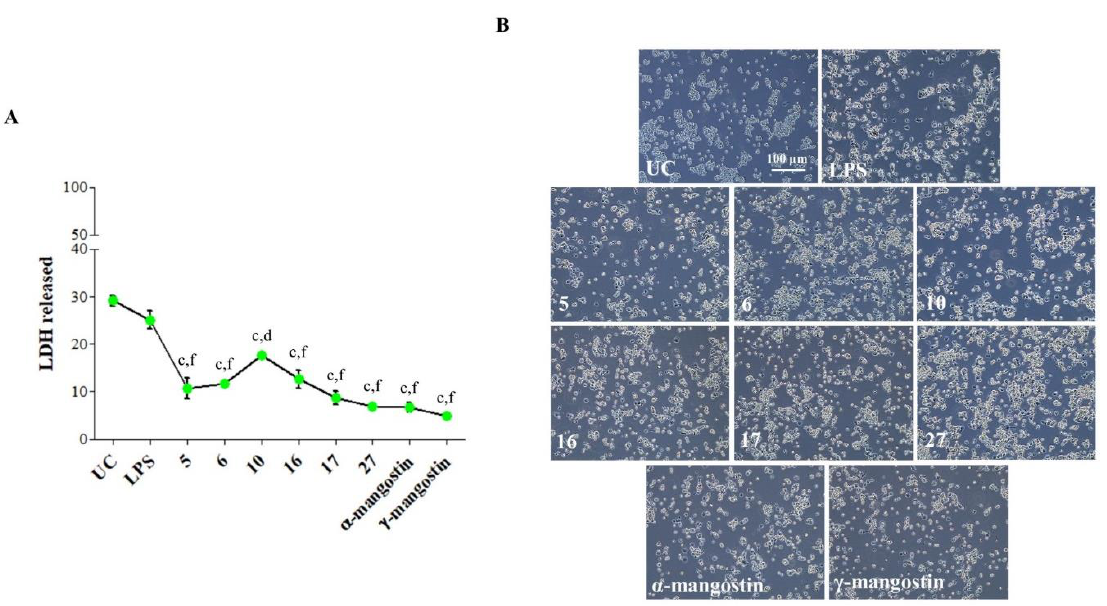
Figure 1. Cytotoxicity occurrence in inflamed macrophages in the presence of compounds 5 , 6 , 10 , 16 , 17 , 27, and mangostins after 24 h of exposure. ( A ) The trend line graph shows the percentage of LDH released from cells in all the experimental conditions. Values are normalized on 3-(4,5-dimethylthiazol-2-yl)-2,5-diphenyltetrazolium bromide (MTT) data obtained from the same experiment. ( B ) Images from a representative experiment. UC = untreated cells (cells pre-incubated with BSO for 18 h). LPS = cells stimulated with 0.5 µg/mL LPS alone. The pure UC (cells exposed to complete RPMI for the entire experimental procedure) was set as 1 (not shown). c = p < 0.0001 between samples and UC; d = p < 0.01 and f = p < 0.0001 between samples and LPS. Representative images from experiments were obtained by optical microscopy (phase-contrast, magnification 100×).